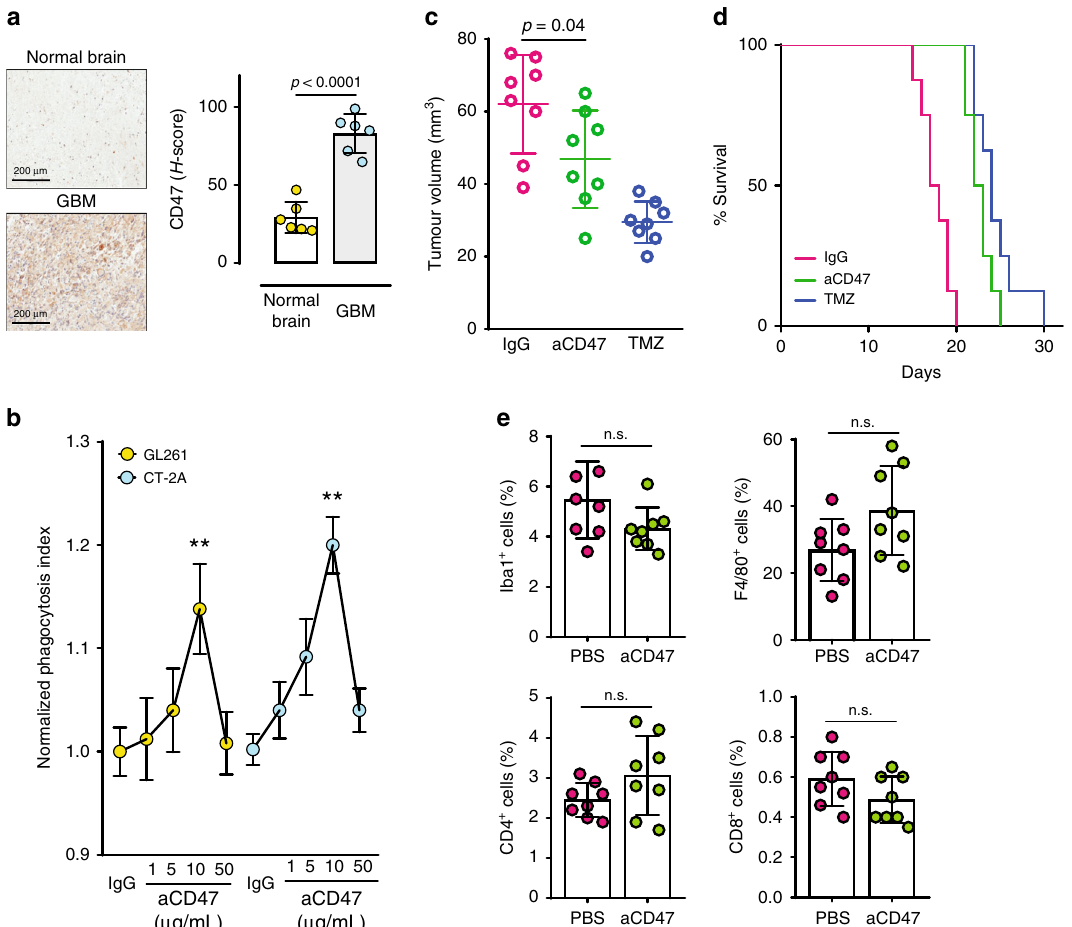
Fig. 1 Blockade of CD47, an anti-phagocytosis molecule over-expressed in glioblastoma (GBM), does not produce signi fi cant antitumor effect. a Immunohistochemistry analyses showing that CD47 expression is signi fi cantly elevated in GBM as compared to normal brain tissues from patient samples. Scale bar = 200 μ m. n = 6/group. Unpaired student ’ s t test. Error bar = mean ± standard deviation. b CD47 blockade resulted in a modest increase in murine GBM cell phagocytosis by BM phagocytes. n = 5/group. ** p < 0.01 compared to IgG (unpaired Student ’ s t test). c The tumor growth inhibitory effect of CD47 blockade was less than temozolomide. n = 8/group. d CD47 blockade did not result in improved animal survival over temozolomide treatment. n = 8/group. p = 0.1 (log-rank test). e No signi fi cant changes were noted in the intratumoral total (F4/80) or activated BM phagocytes (Iba1), CD4 + or CD8 + T cells after anti-CD47 antibody treatment. n = 8/group. Error bar = mean ± standard deviation. n.s. not signi fi